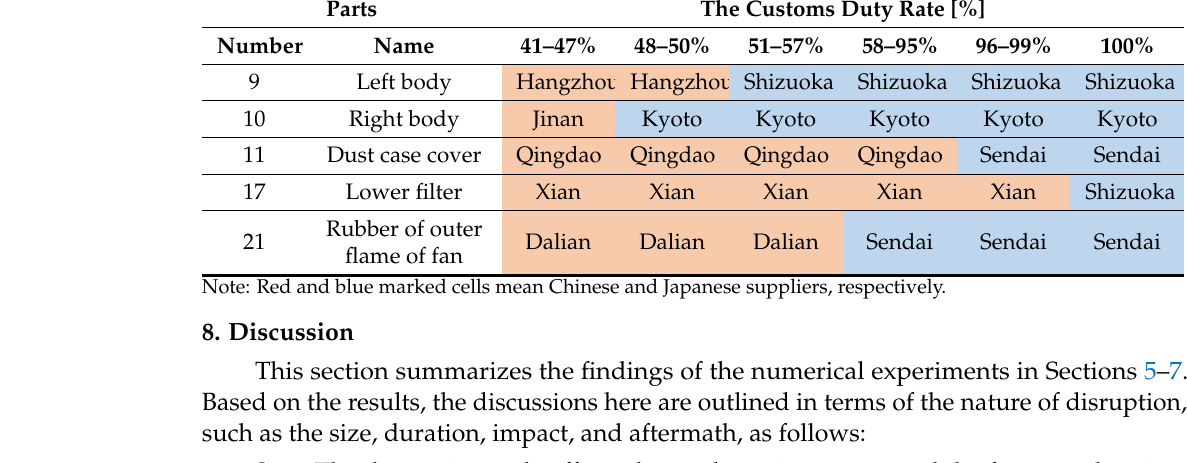
Table 8. The customs duty rates and the choice of foreign supplier for the Kuala Lumpur factory.